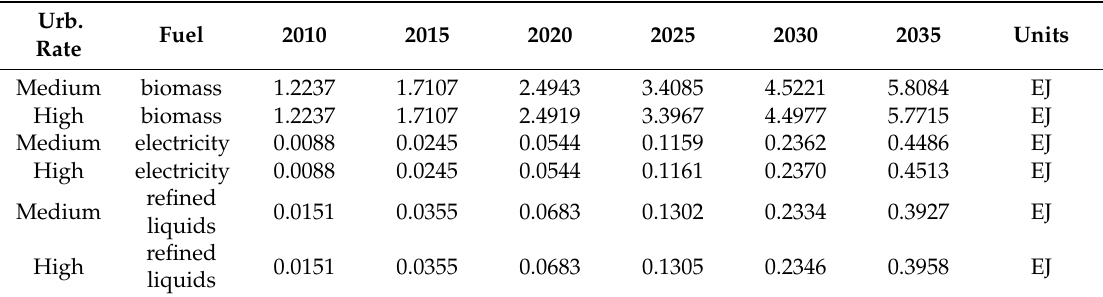
Table 7. Comparison of Building Energy Demand by Fuel between Two Urbanization (Urb.) Rates using the Reference GDP.